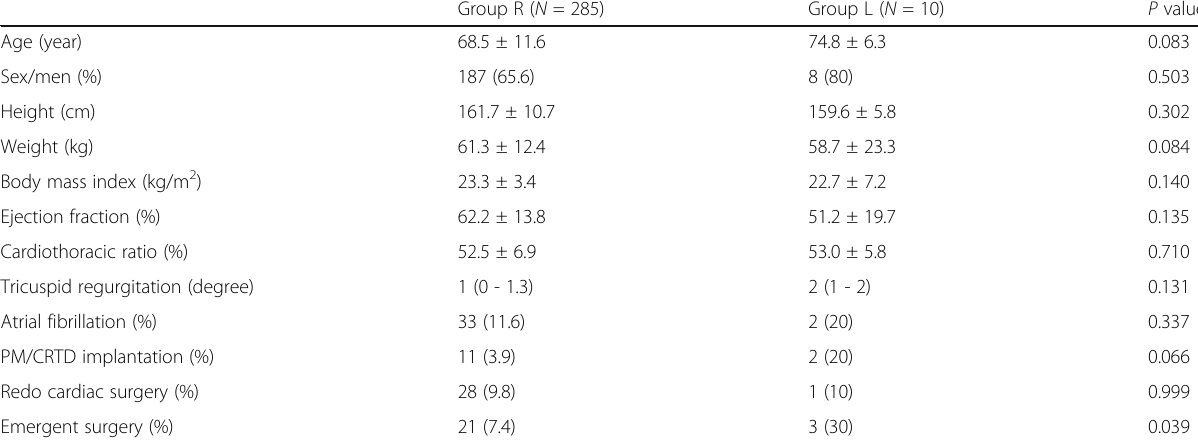
Table 1 Patient characteristics and clinical data